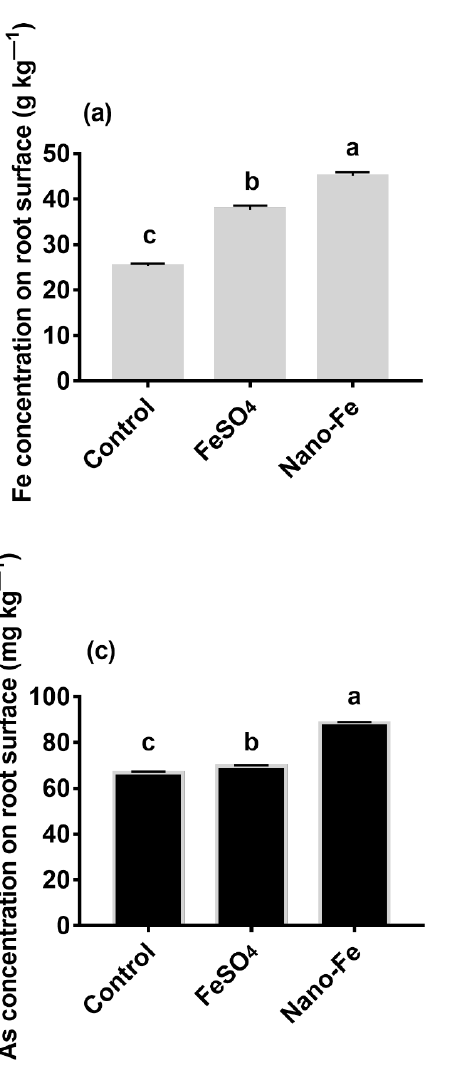
Exogenous Fe reduced ( p < 0.05) the Cd concentrations (Figure 2a – c) and its uptake (Figure 2d – f) in the roots, shoots, and grains, reduced ( p < 0.05) the As concentrations (Figure 3a – c) and its uptake (Figure 3d – f) in the roots, shoots, and grains of rice, compared with the control.